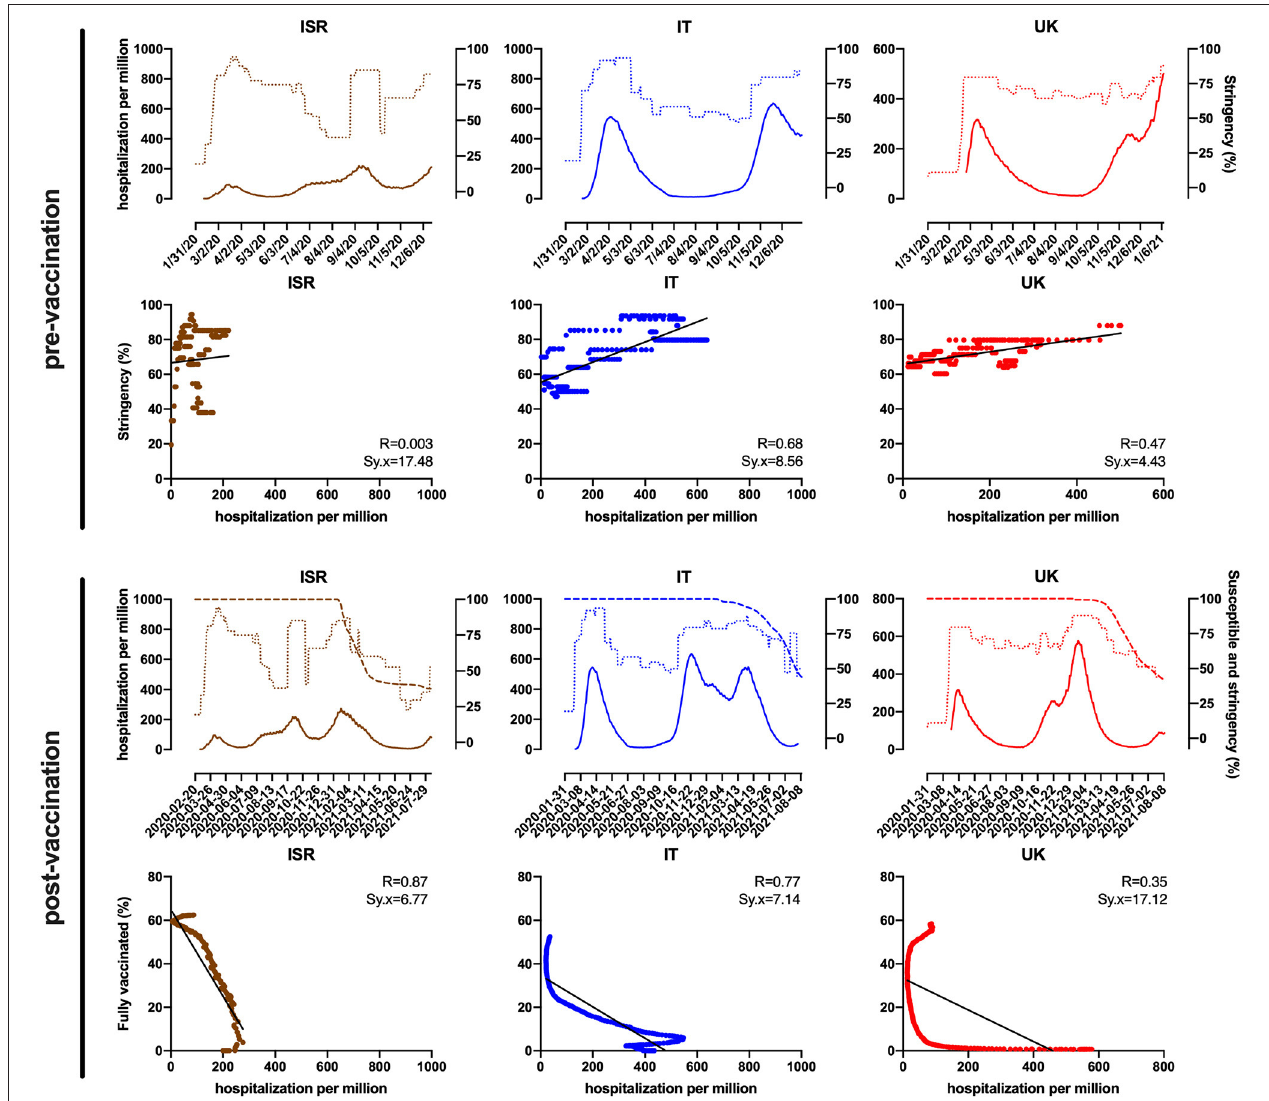
FIGURE 1 | Israel (ISR), Italy (IT), and the United Kingdom (UK) trend (top) and correlation (below) of hospitalizations per million (hard line) as a function of stringency index (dotted line) between January 2020 and the beginning of mass vaccination rollout (pre-vaccination) and as a function of fully vaccinated (%) and susceptible individuals (%) defined as individuals who did not receive full vaccination (dashed line), between December 2020 and August 2021 (post-vaccination). Data were obtained and modified from the WHO COVID-19 Situation Reports and Our World in Data (Mathieu et al., 2021; WHO,